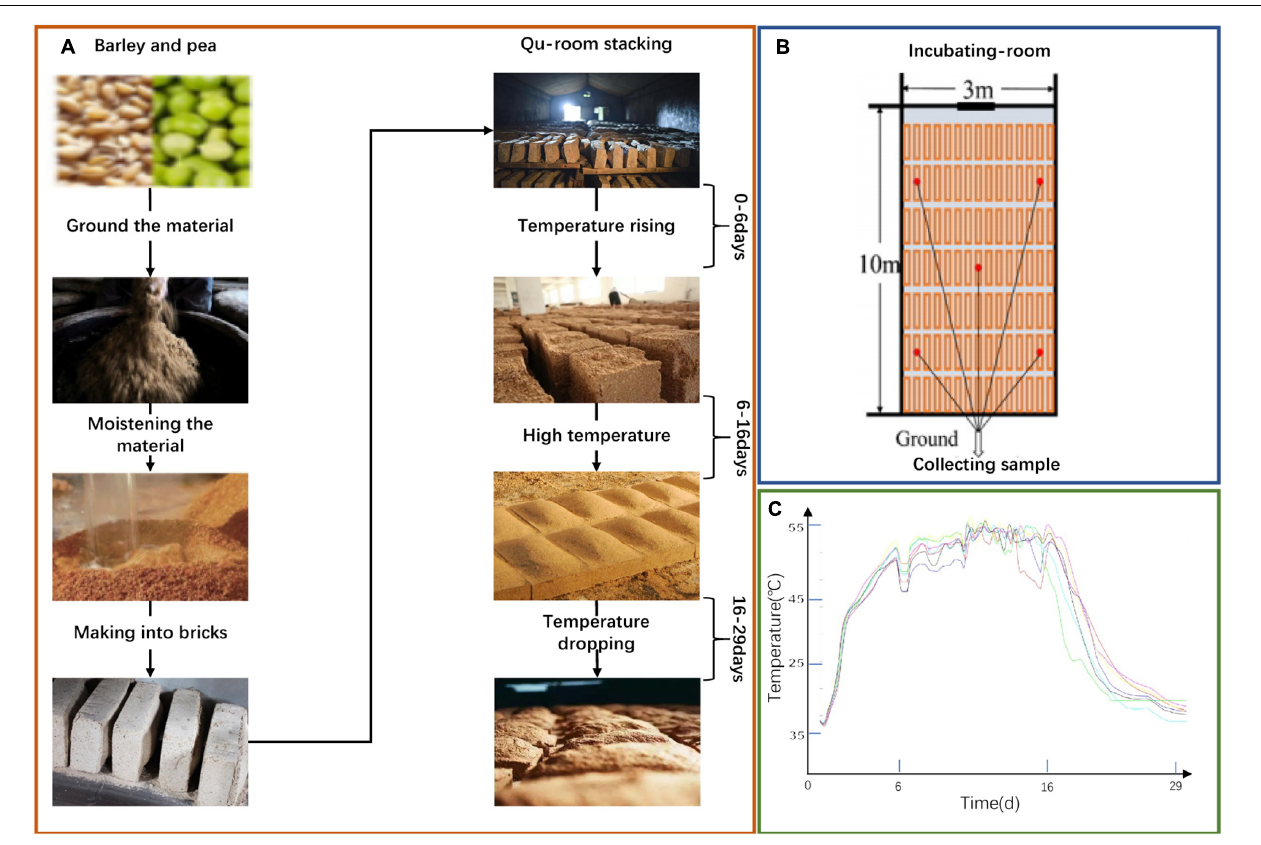
FIGURE 1 | A schematic of the production process of NongXiang Daqu (A) . A Schematic diagram of increasing room (B) . Temperature curve of the fermentation process (C)